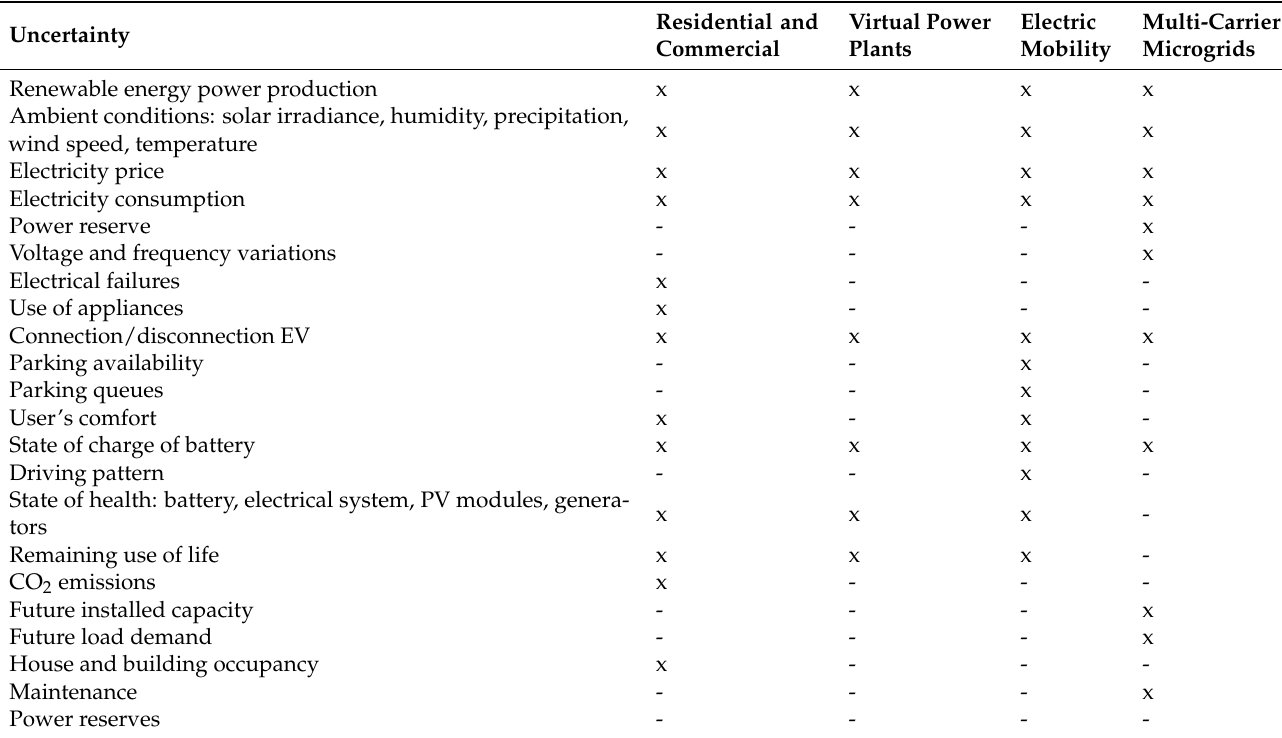
Table 2. Uncertainties considered in various